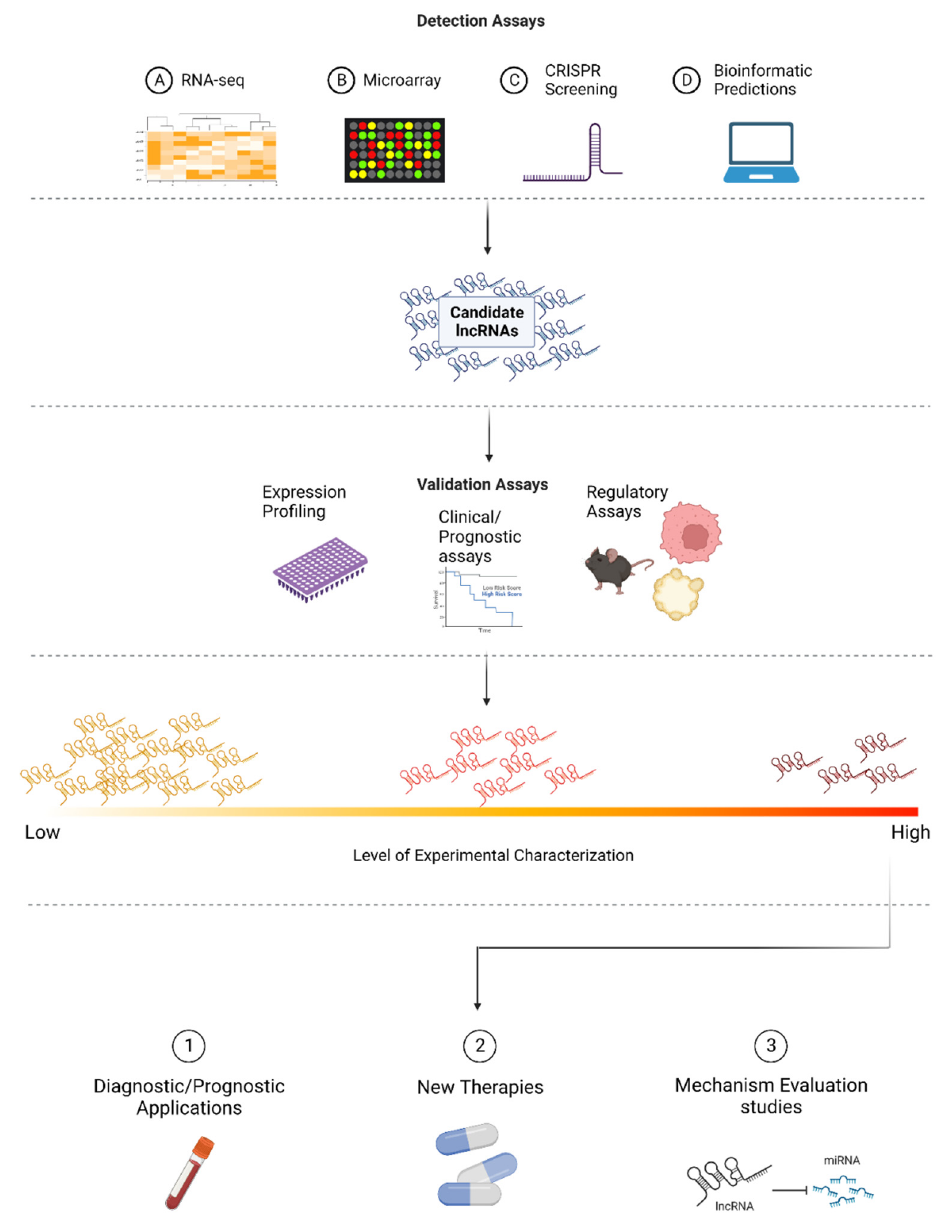
Figure 2. Methods for detecting and validating lncRNA biomarkers in CRC. After detection of candidate lncRNAs via the methods shown above (see text for full descriptions), validation techniques are used to characterize and assess which candidate lncRNAs are the most suitable for future studies. Regulatory assays may be carried out in cell lines, organoids, or in vivo models. Well characterized lncRNAs can be used as diagnostic/prognostic tools, as targets in future therapies, and as subjects of mechanistic studies. Created with Biorender.com.